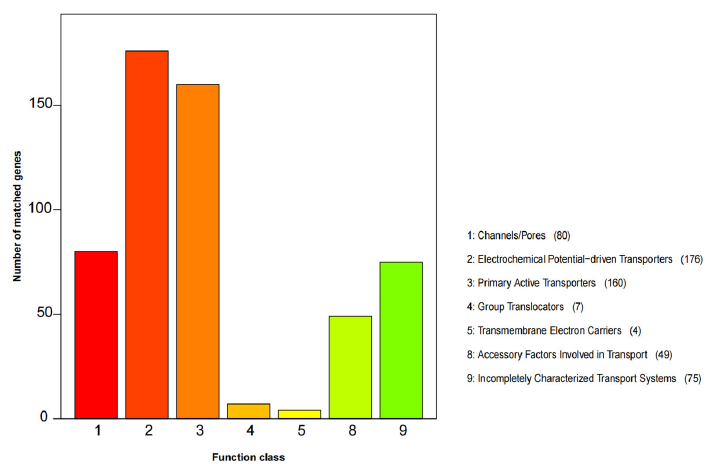
Figure 4. TCDB function classification of C. mycophilum BJWN07.